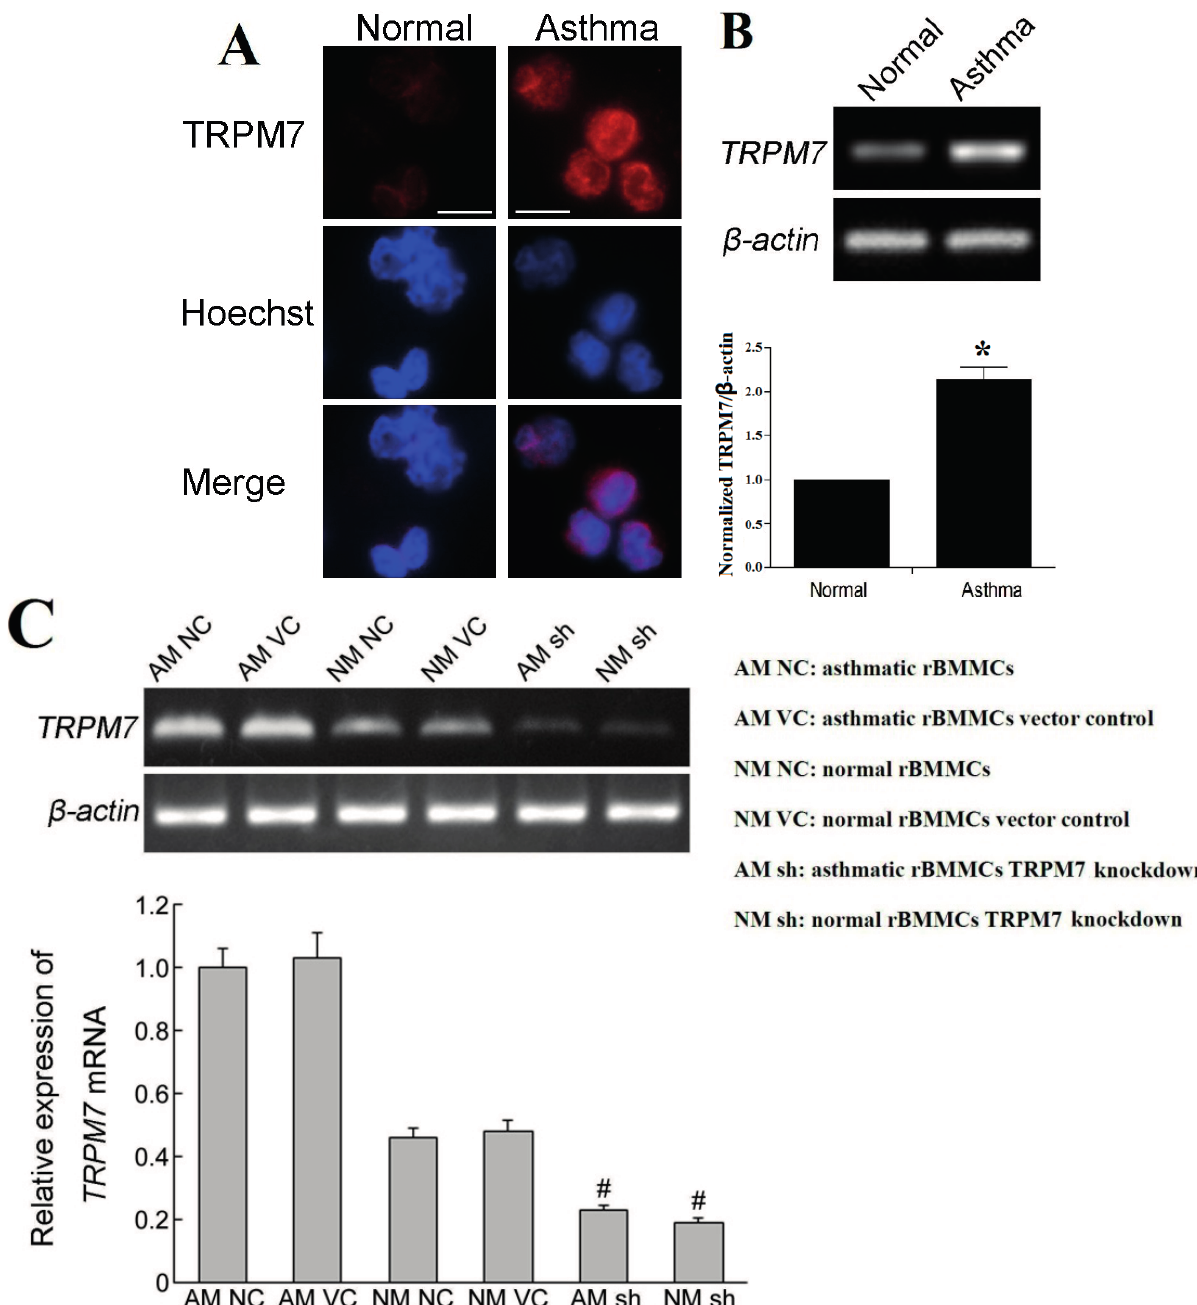
Figure 3. Expression of the transient receptor potential melastatin 7 (TRPM7) in rat BMMCs. ( A ) Immunocytochemistry of TRPM7 in rat BMMCs. Scale bar = 20 µm; ( B ) mRNA expression of TRPM7 detected by RT-PCR. The mRNA levels of TRPM7 were significantly increased in asthmatic group compared to the normal group ( * p < 0.05); ( C ) Expression of TRPM7 mRNA detected by RT-PCR. The mRNA levels of TRPM7 were significantly decreased in TRPM7 knockdown groups ( # p <